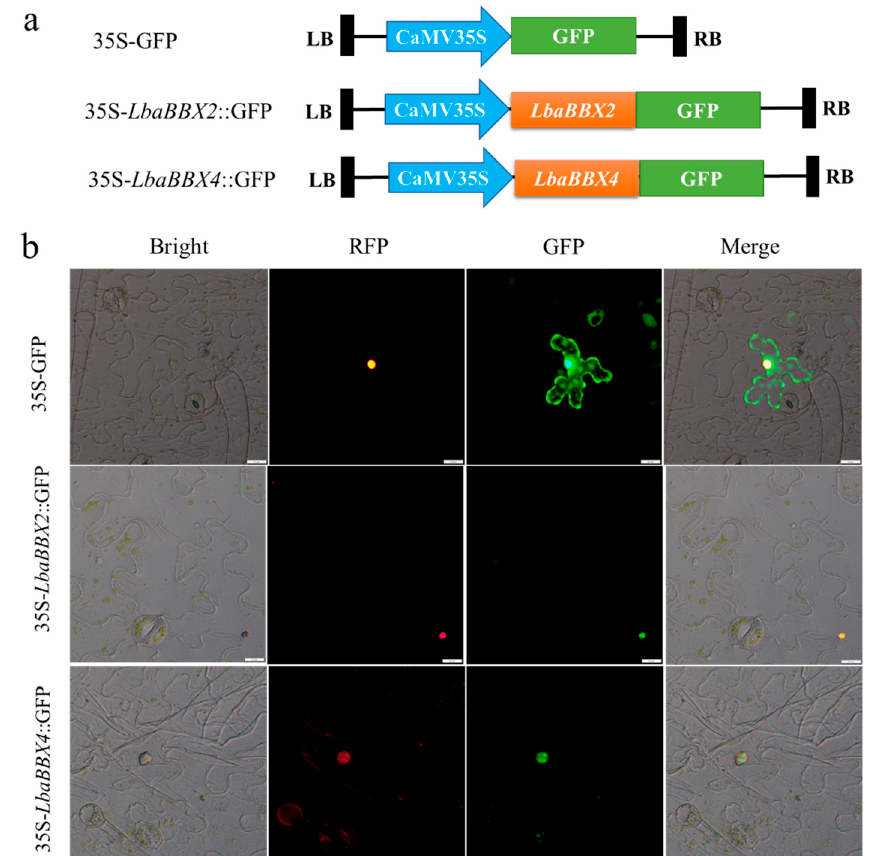
Figure 10. Subcellular localization of LbaBBX4 protein. ( a ) Schematic diagram of the 35S-GFP, 35S- LbaBBX2 ::GFP, and 35S- LbaBBX4 ::GFP fusion protein constructs used for transient expression. ( b ) The LbaBBX2-GFP and LbaBBX4 -GFP fusion proteins were transiently expressed in N. benthamiana leaves and observed by fluorescence microscopy 48 h later. The 35S-GFP was used as positive control. From left to right, bright field, red fluorescent protein (RFP) (nuclear localization signal (NLS)-RFP), green fluorescent protein (GFP), and merge image of RFP and GFP image. Scale bars =20 μ m.